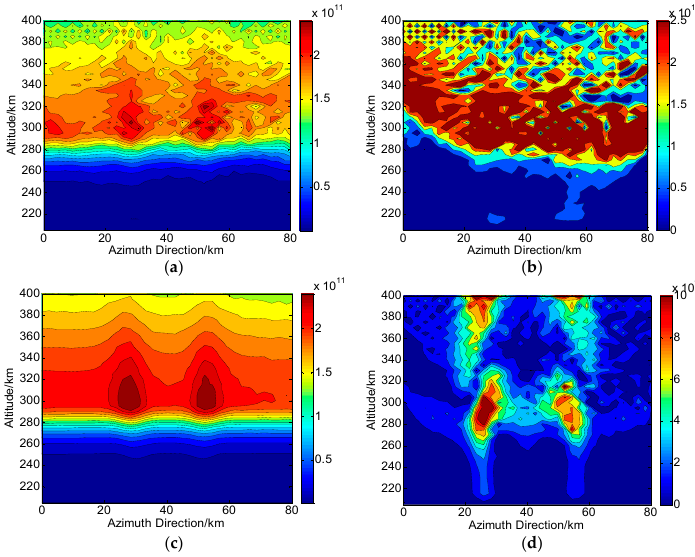
Figure 8. Two-dimensional CIT reconstructions under the condition of system noise in Qingdao ( BB Ω is used). ( a , c ) are the reconstructed results with SNR = 5 dB and SNR = 20 dB, respectively. ( b , d ) are the corresponding absolute deviations between the true and reconstructed results. The unit of the electron density is electrons · m − 3